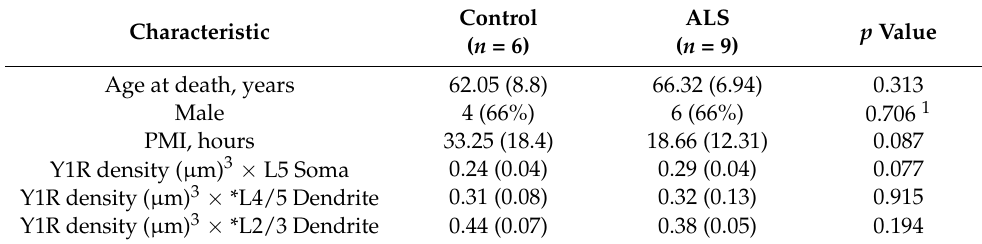
Table 3. Comparison of ALS case and age-matched control